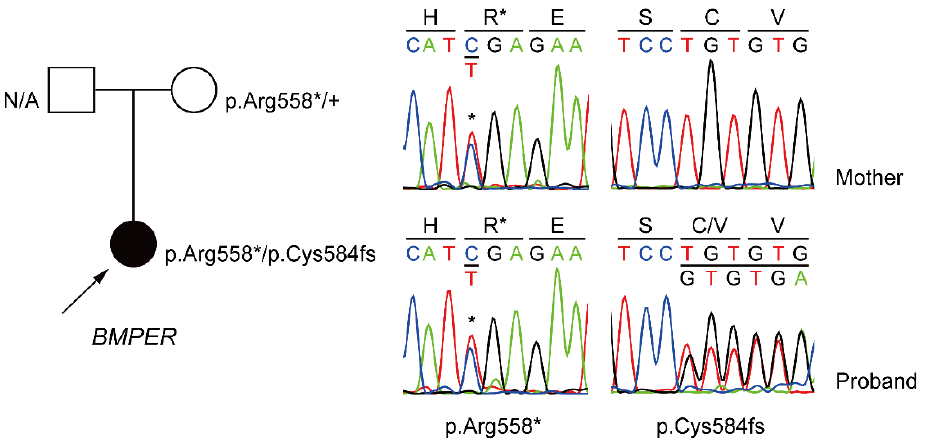
Figure 2. Family pedigree and mutation in the patient and Sanger sequencing traces confirming the compound heterozygous variants in the BMPER gene. *, termination codon; fs, type of change is a frameshift.